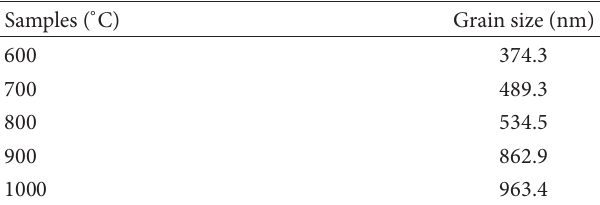
Figure 6: FTIR spectra of various percentages of Eu 2 O 3 doped willemite samples sintered at 1000 ∘ C for 4 h.